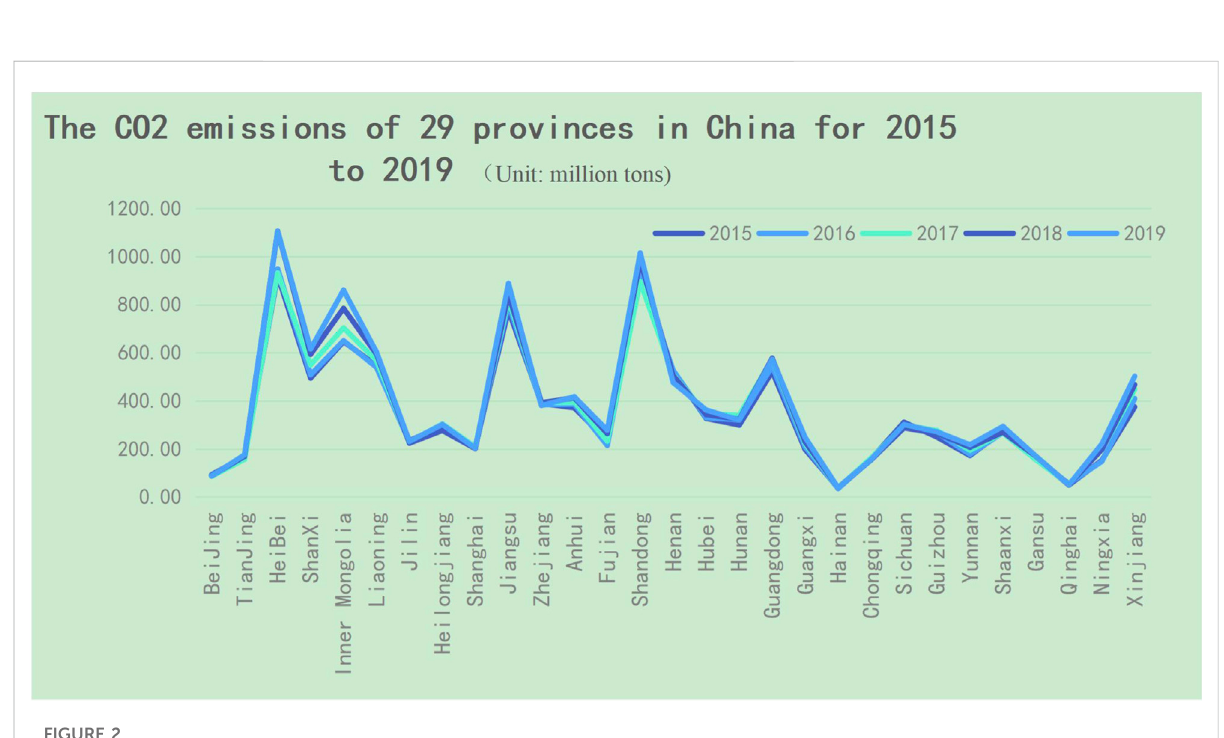
FIGURE 2 The CO2 emissions of 29 provinces in China for2015 to